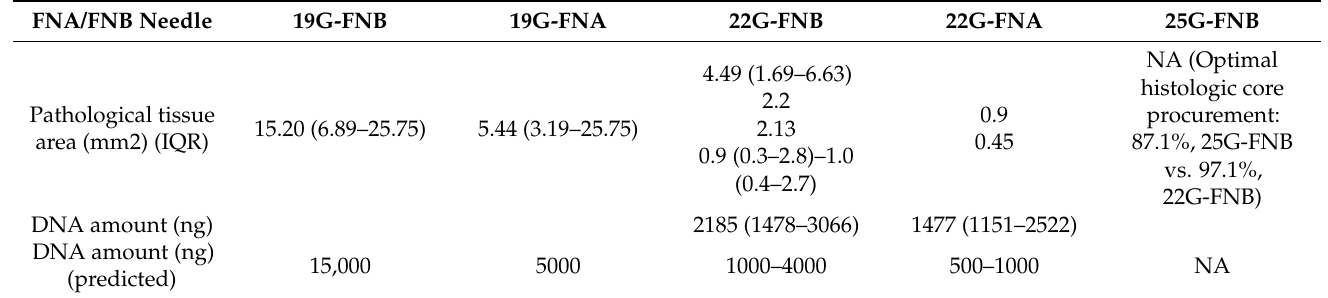
Table 2. Relationship between needle size and sample volume in FNA/FNB for a pancre- atic/peripancreatic